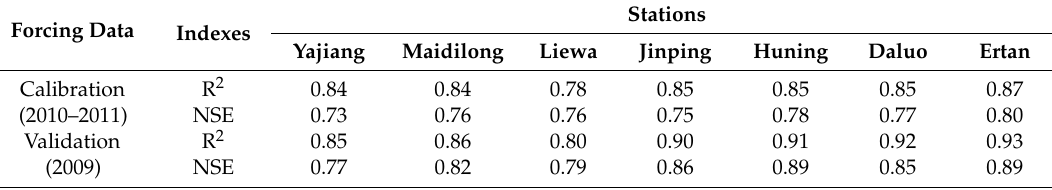
Table 5. Evaluation indexes for the simulation result at the daily scale in Yalong River Basin.